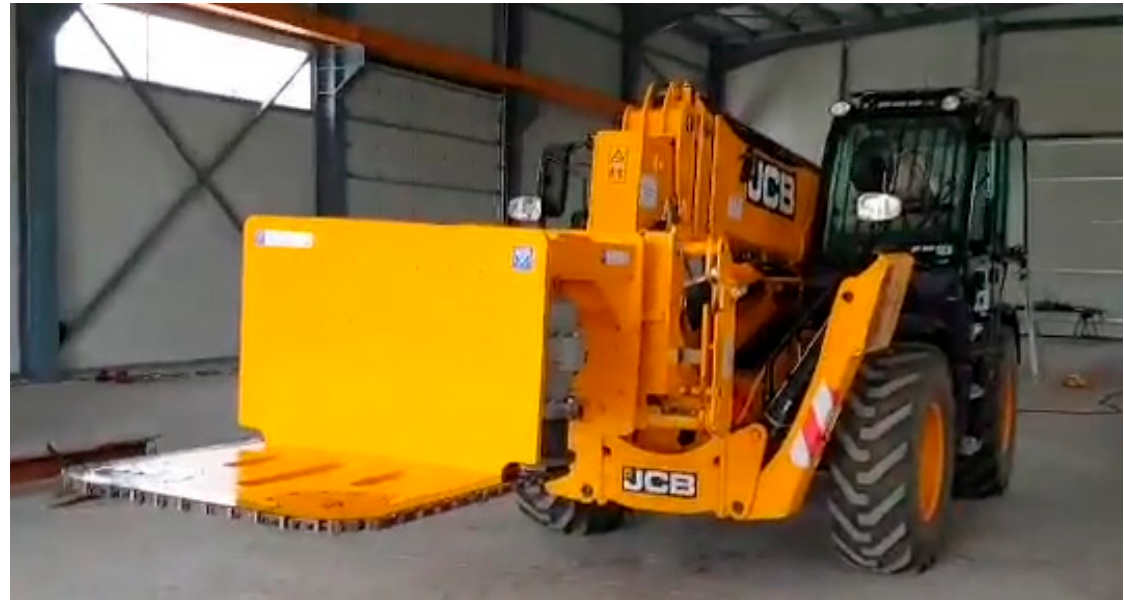
Figure 1. The basic machine with the mining adapter.